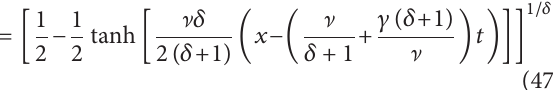
Figure 7: The absolute error of problem (40) where ] = 10 , 𝜇 = 0.1 , 𝑐 = 0.1 , 𝛼 = 𝛽 = −1/2 , and 𝑁 = 16 .